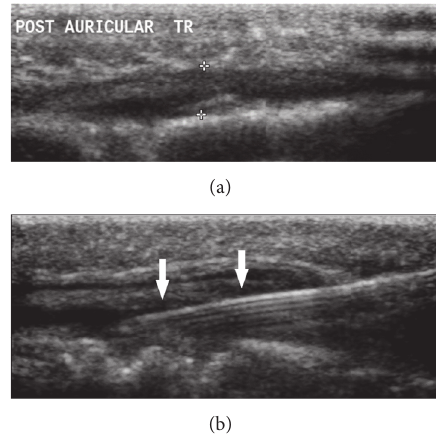
Figure 3: (a) Ultrasound imaging depicting the hypoechoic mass within the right postauricular soft tissues (cursors); (b) ultrasound guided FNA of extracranial extension of intracranial mass, with arrows indicating the needle with the